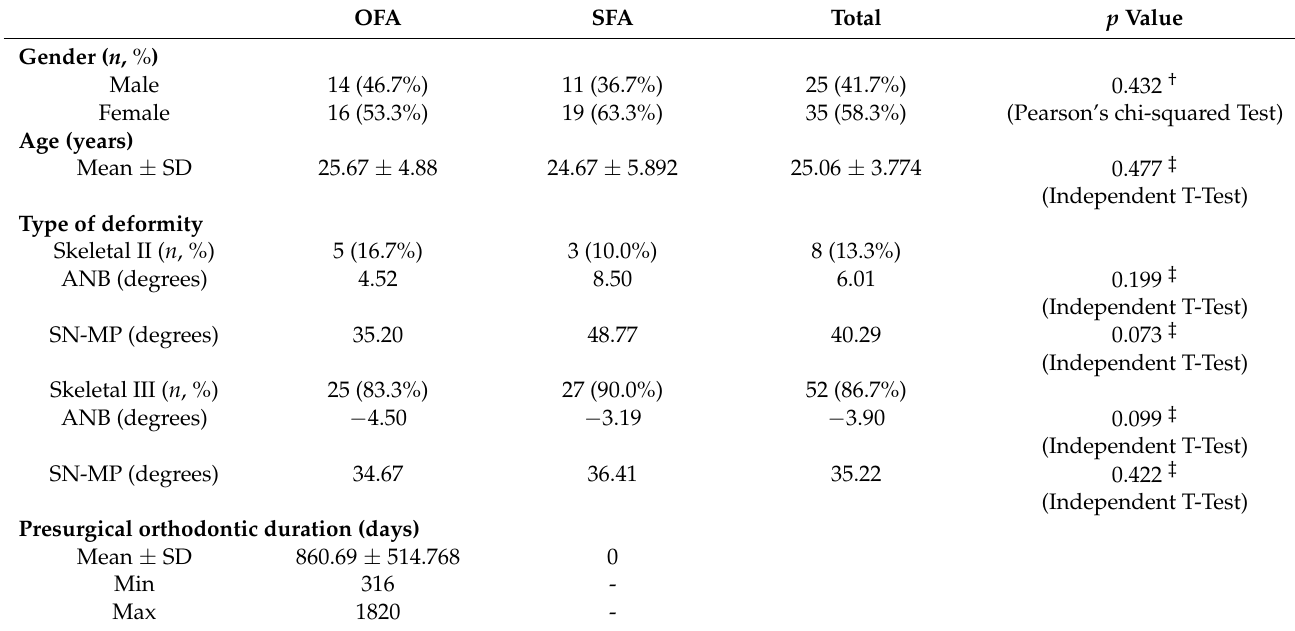
Table 1. The demographic data were compared by using Pearson’s chi-squared test ( † ) for gender, and the independent T-test ( ‡ ) for age. The cephalometric data were compared by using the independent T-test ( ‡ ). The duration of the presurgical orthodontic phase is also exhibited in the table. OFA